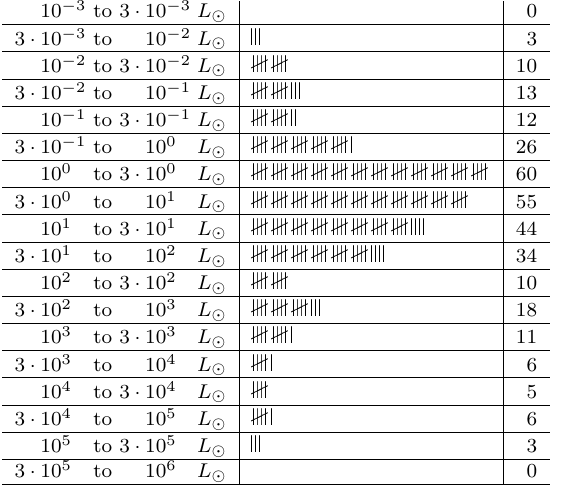
rive properties such as a star’s average density.